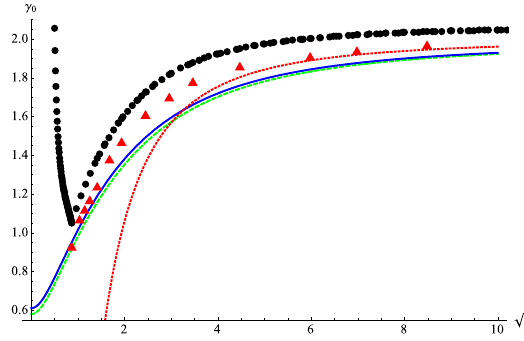
( (cid:28) ) at the duality invariant points with Figure 5 . Comparison of the interpolating function F (30 ; 1 = 4) 4 the N = 4 superconformal bootstrap for the spin-0 case. The horizontal axis denotes the square p root of the central charge: a . The black circle symbols are the upper bounds of the anomalous dimension by the N = 4 superconformal bootstrap while the red triangles are the corner values. ( (cid:28) TS ), respectively. The red ( (cid:28) S ) and F (30 ; 1 = 4) The green dashed and blue solid lines are F (30 ; 1 = 4) 4 4 dashed line shows 2 (cid:0) 16 =N 2 , which is obtained by numerical (cid:12)tting of the corner values in the large- a regime